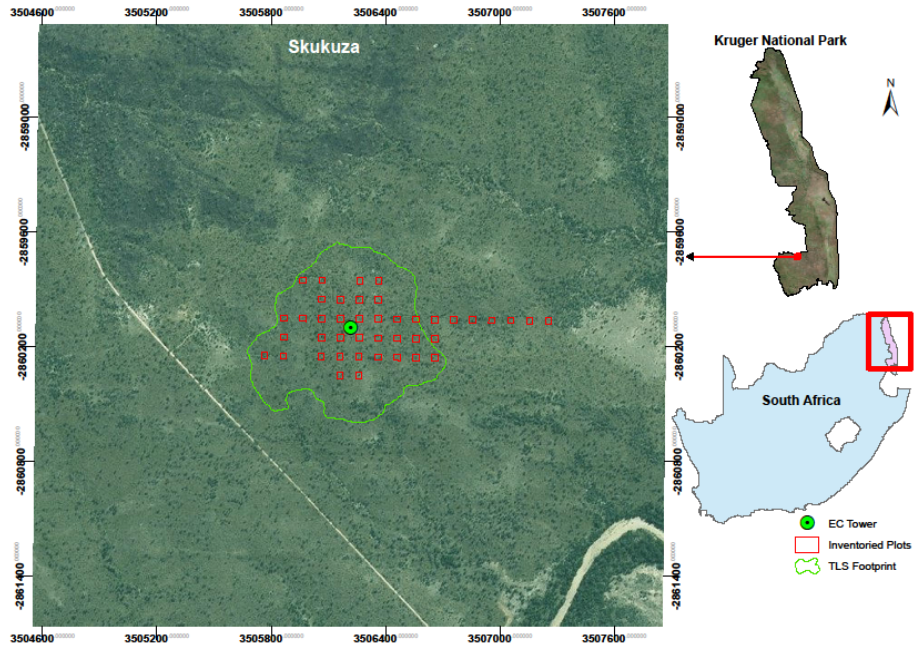
Figure 1. Imagery showing location of the study site in Skukuza, inventoried plots and terrestrial laser scanner (TLS) footprint. The study is centered around the Skukuza eddy covariance tower (EC Tower) as shown in the map. (Imagery source: Google Earth/Digital Globe).